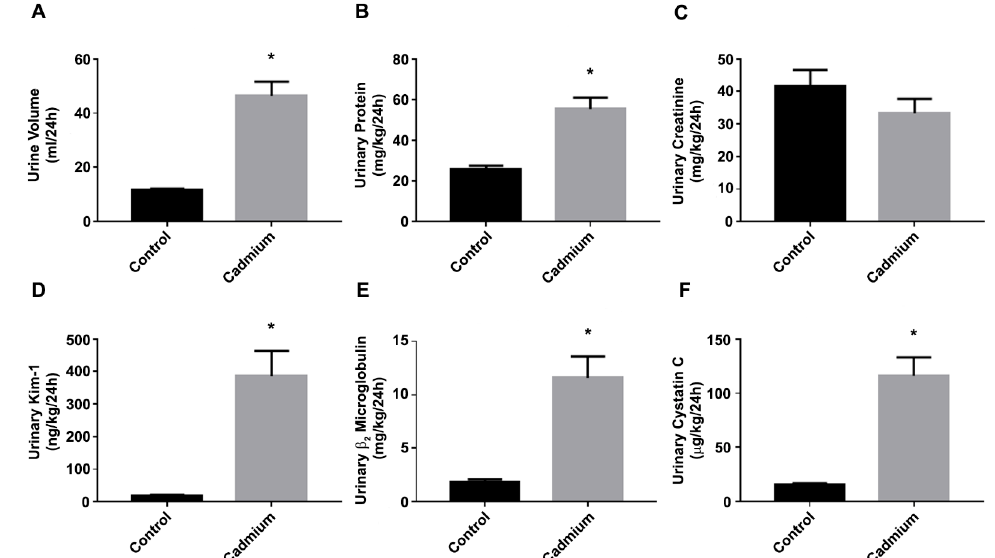
Figure 1. Assessment of Cd-induced nephrotoxicity in a 12-week sub-chronic rat model. Male Sprague-Dawley rats received daily subcutaneous injections of Cd (0.6 mg/kg/day) 5-days a week for 12 weeks, while the controls received injections of isotonic saline. ( A ) Urine volume; ( B ) urinary protein; ( C ) urinary creatinine; ( D ) urinary Kim-1; ( E ) urinary β 2 microglobulin; ( F ) urinary cystatin C. The data are mean ± SEM; an asterisk (*) indicates statistical significance from the saline control ( N = 6 per group, unpaired t -test, p ≤ 0.05).